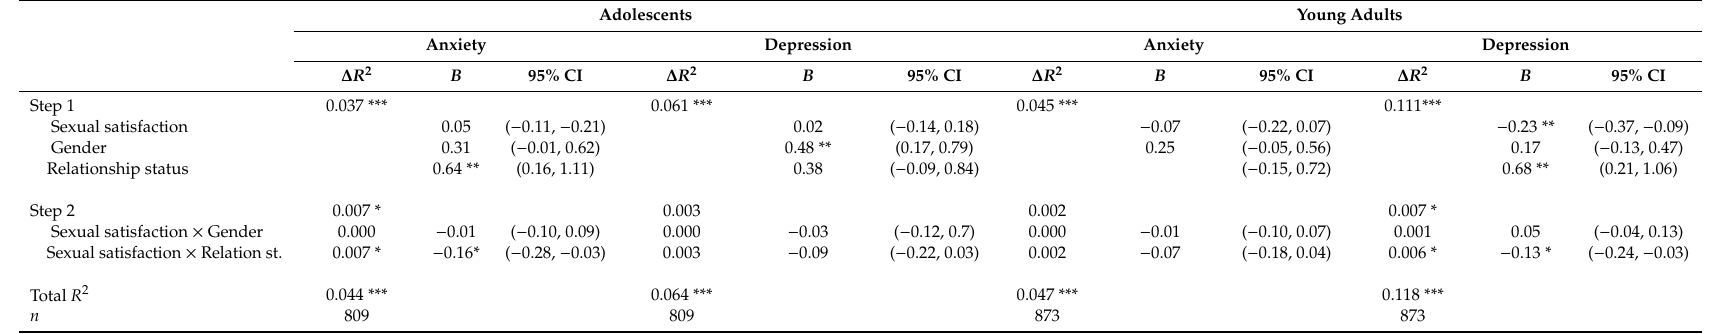
Table 2. Regression models with the macro PROCESS including sexual satisfaction as a predictor of anxiety and depression, and gender and relationship status as moderators for adolescents and young